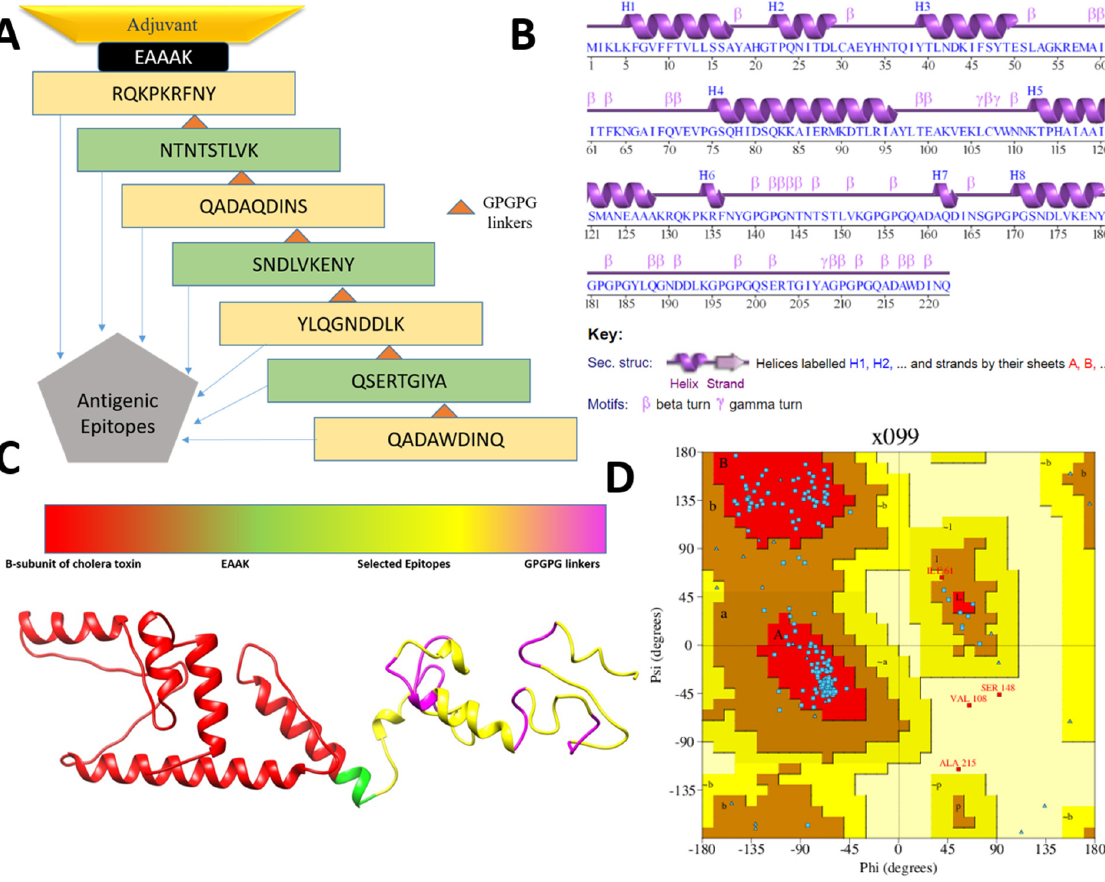
Figure 3. Schematic vaccine design ( A ), secondary structure of the vaccine ( B ), 3D structure of the vaccine ( C ) and Rama- chandran plot of the vaccine ( D ). Table 3. Refined vaccine models together with different parameters. The refined models are ranked on basis of galaxy energy.